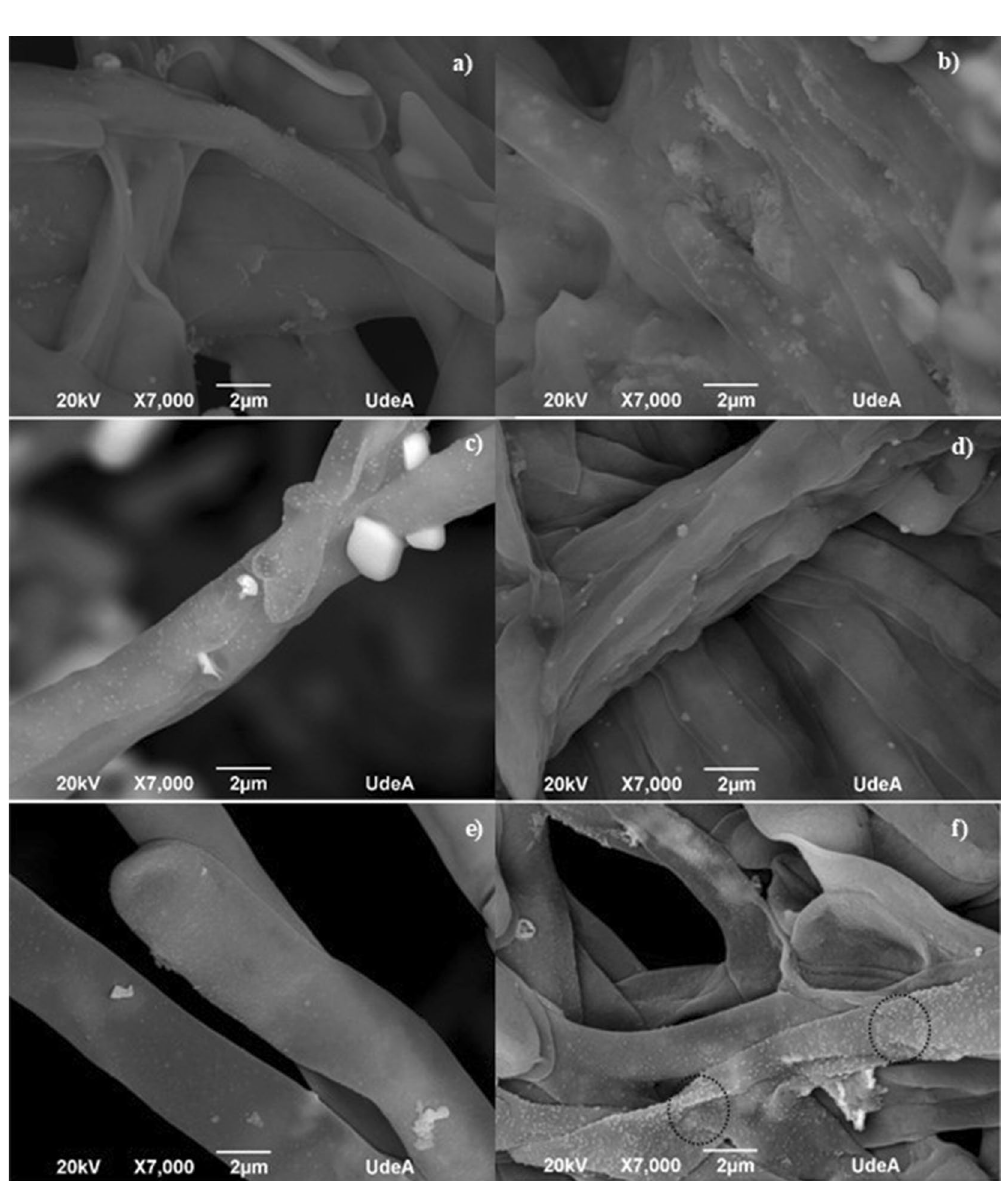
Figure 11. SEM micrographs of the fungal mycelium anamorphous Bjerkandera sp. R1 treated with a 1 mM